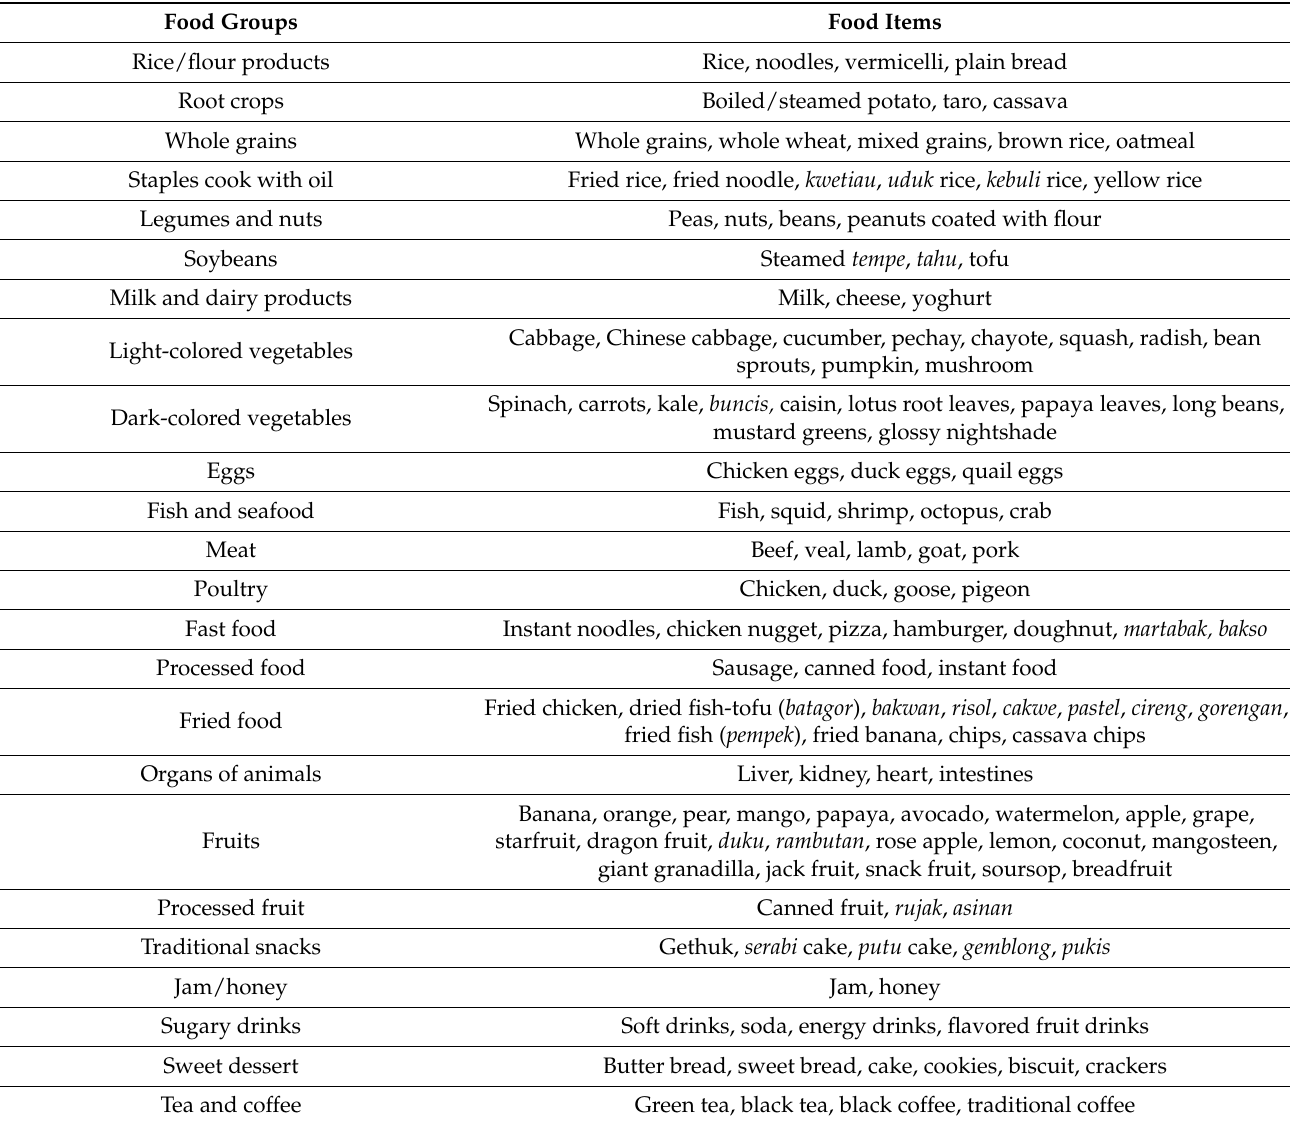
Table 1. Food groups and food items used in the food frequency